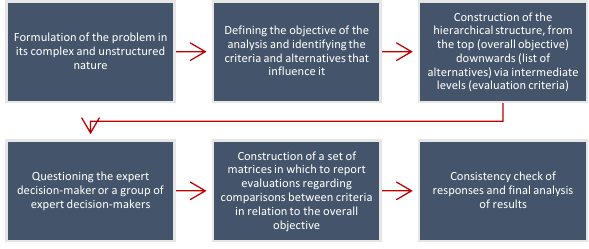
Figure 1 . Logical sequence of